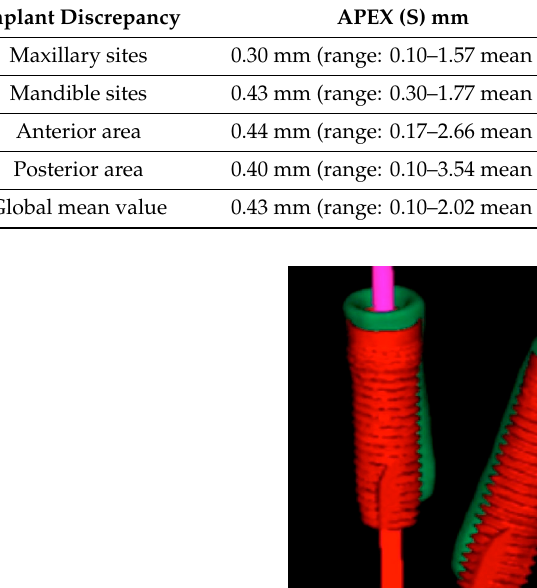
Table 2. The horizontal apex (S) and neck (V) implant discrepancies.